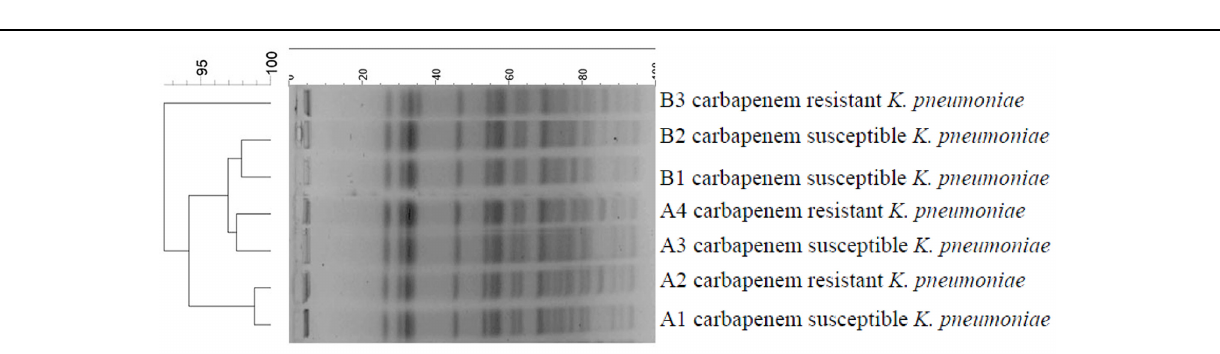
FIGURE 1 | Plasmid DNAs from Klebsiella pneumoniae strains (A) and Southern hybridization of plasmid DNAs with a bla − NDM − 1 probe (B). Lane 1: A1, Lane 2: A2, Lane 3: A2-conjugant, Lane 4: B2, Lane 5: B3, Lane 6: B3-conjugant.